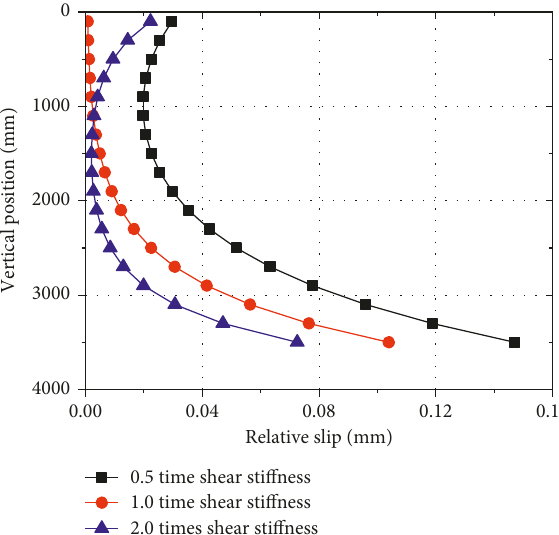
Figure 15: Load-slip curve with various shear stiffness.